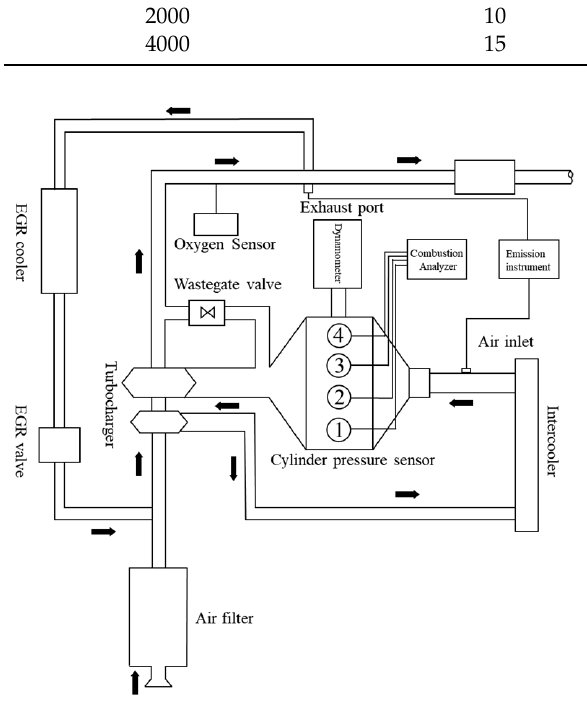
Figure 1. Engine bench layout. Table 3. Test operating point.